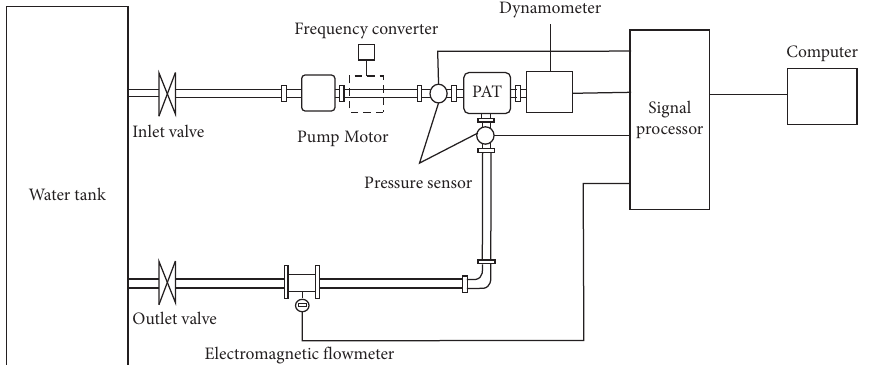
Figure 6: Schematic diagram of turbine performance test bench.